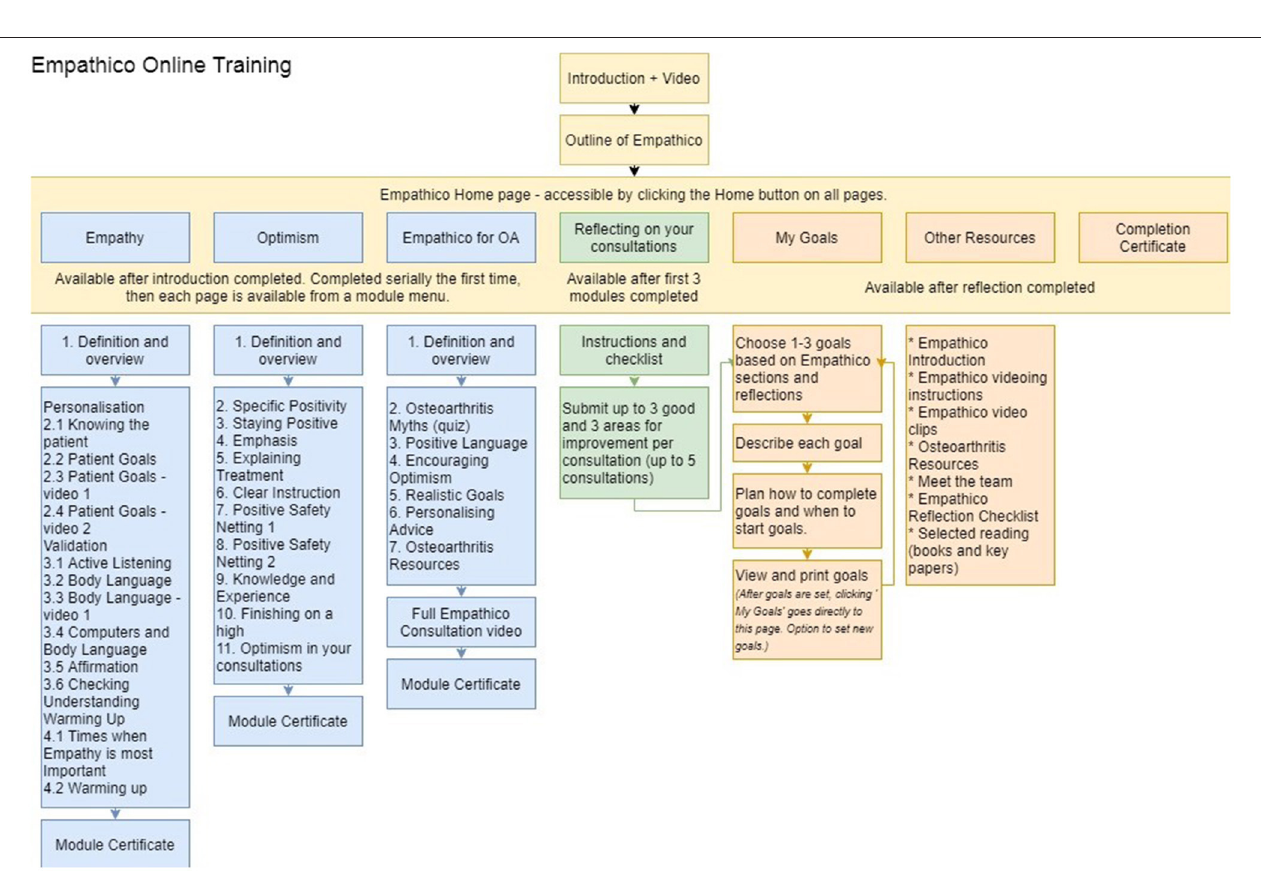
FIGURE 3 | Overview of the Empathico structure and